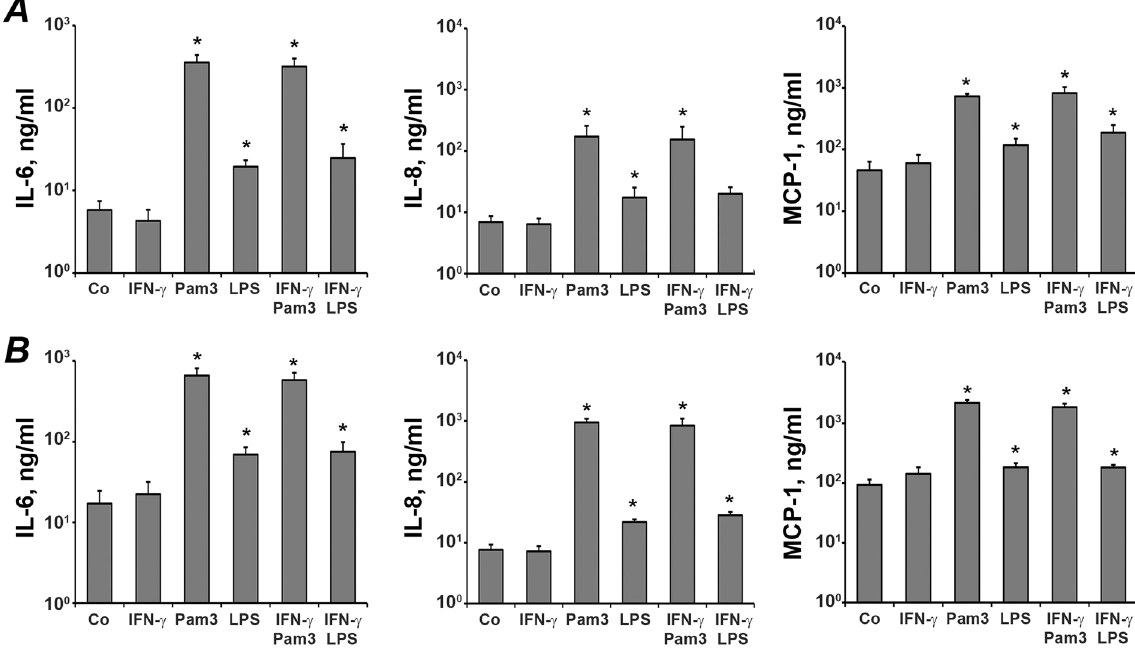
Figure 4. Effect of IFN- γ , Pam3CSK4, and E. coli LPS on production of IL-6, IL-8, and MCP-1 protein by hPDLSC. Cells were stimulated with IFN- γ (10 ng/ml), TLR2 agonist Pam3CSK4 (1 µ g/ml), TLR4 agonist E. coli LPS (1 µ g/ml), or combinations of IFN- γ and TLR agonists for either 6 h ( A ) or 48 h ( B ) and concentration of IL-6, IL-8, and MCP-1 protein in conditioned media were measured by ELISA. Data are presented as mean ± s.e.m. of 6 different donors. * significantly different compared to